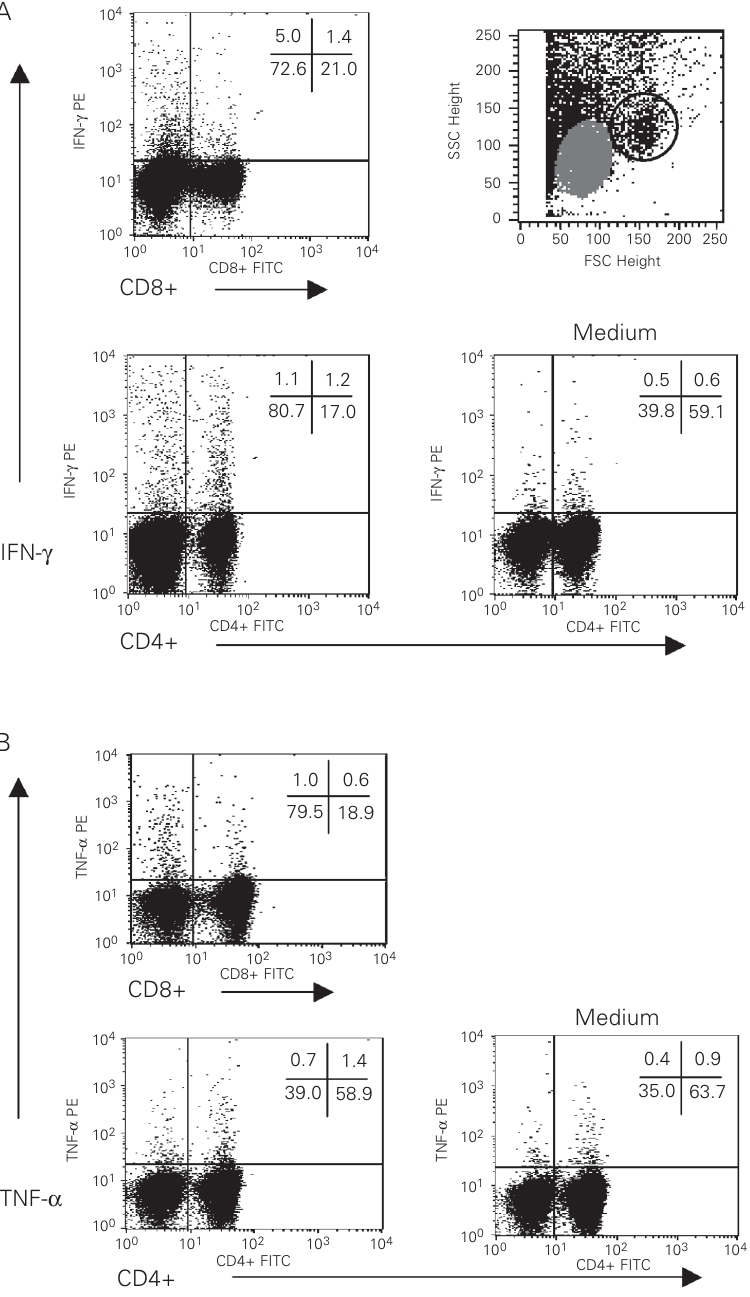
Figure 3. Typical profiles of IFN- γ (A) and TNF- α (B) intracellular expression in CD4+ and CD8+ T cells from purified protein derivative- or Mycobacterium leprae -stimulated periph- eral blood mononuclear cells, respectively. Cytokine production after specific antigenic stimuli (10 µg/ml) was enhanced by the addition of purified anti-human CD28 antibody (at 3 µg/ml) and brefeldin A in representative tuberculosis and leprosy patients. The inset in A shows the light scattering of the two distinct populations (gray and circle regions indicating small and blast cells, respectively) gated on the basis of their properties. Percentages of cells for the respective quadrants are indicated in each